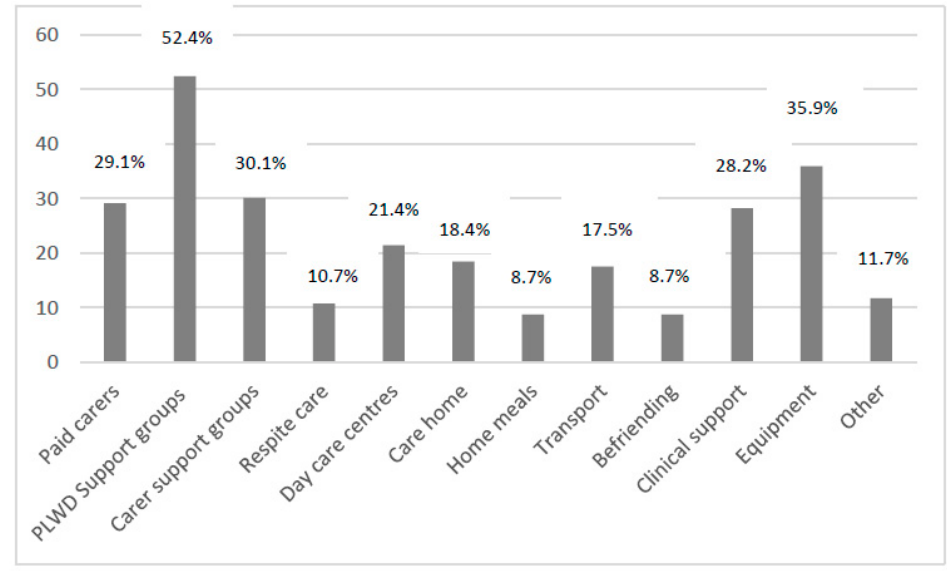
Figure 1. Number of services utilised. Legend. X-axis shows the number of combined services a participant was accessing. Y-axis shows the number of people who accessed a given number of services.